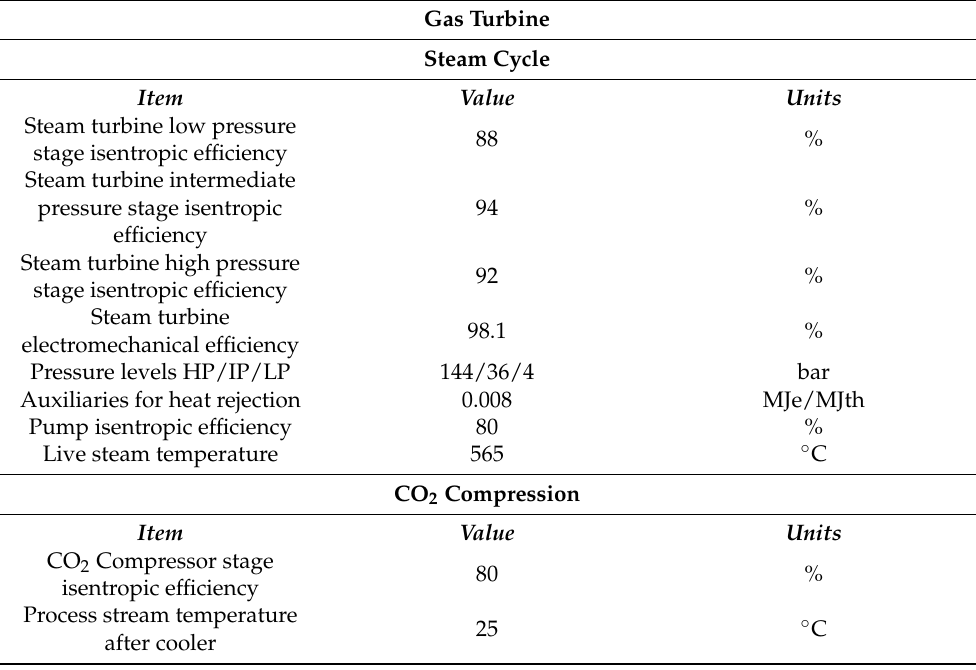
Table A3. Power cycle